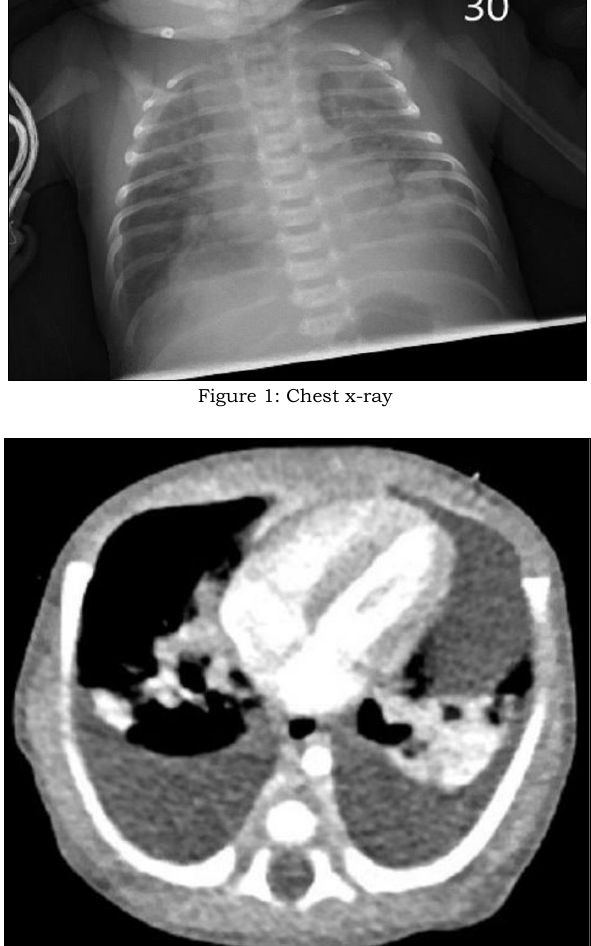
Figure 2: CT scan showing bilateral pleural effusion.